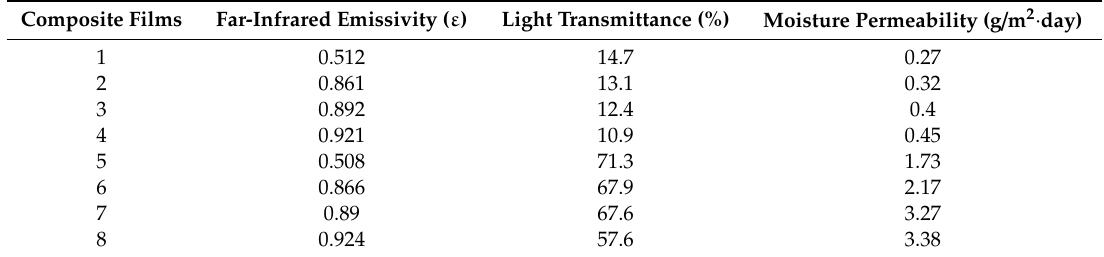
Table 3. Far-infrared emissivity, light transmittance, and moisture permeability of the composite films. Composite Films Far-Infrared Emissivity ( ε ) Light Transmittance